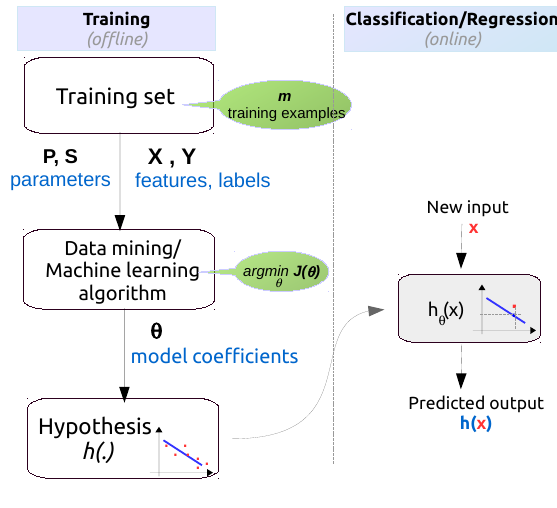
Figure 7. The supervised learning process: training phase ( Left ) and classification/regression ( Right